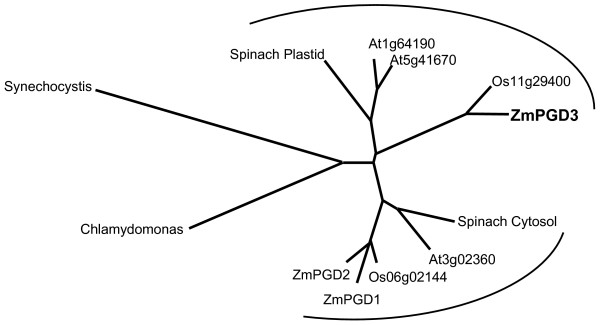
Sequence similarity tree of 6PGDH enzymes. Sequence similarity tree of 6PGDH enzymes from maize (Zm), rice (Os), Arabidopsis (At), spinach, Chlamydomonas reinhardtii, and Synechocystis sp. PCC 6803. Rice and Arabidopsis proteins are identified by their locus numbers. The protein sequences used to generate the ClustalW alignment and tree were from the ORF of the Pgd3 locus and Genbank accessions: AAC27702, AAC27703, AAK49897, AAK51690, AAL76323, AAO42814, ABA93694, NP_198982, NP_442035, NP_850502, NP_910282.